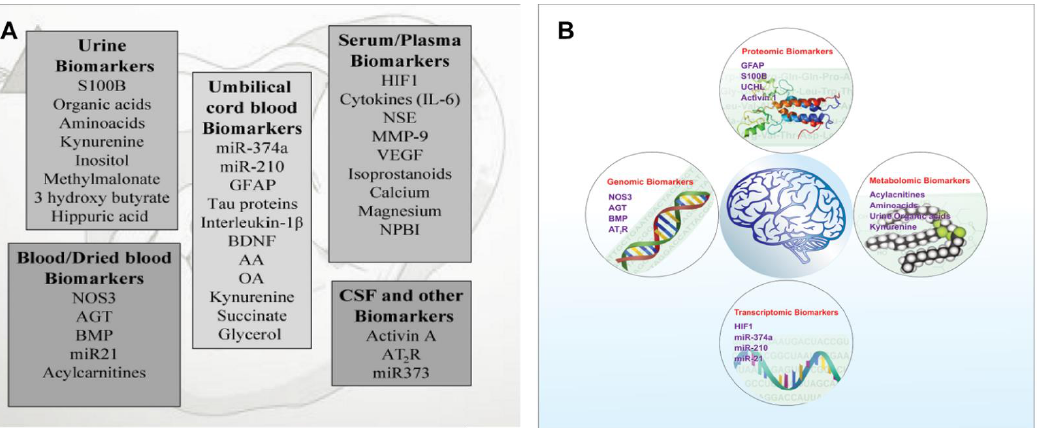
Figure 4. Summary of omics in HIE. ( A ) The biomarkers found in a variety of body fluids, indicating the severity and presence of HIE. ( B ) Biomarkers of HIE as per their biochemistry.